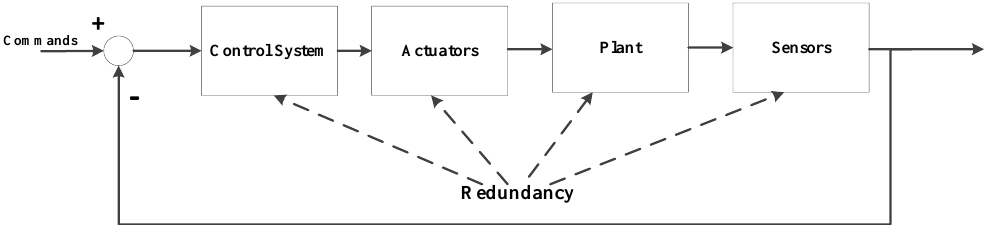
Figure 3. Passive FTC Structure: This kind of controller can be designed by considering redundant controller/actuator/plant/sensor and in the presence of fault will switch to the redundant